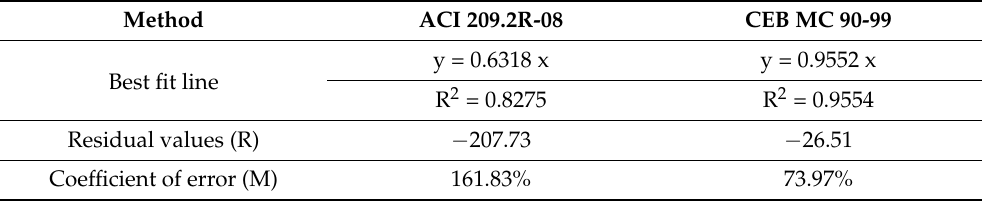
Figure 8. Evaluation of the ACI 209.2R-08 ( a ) and CEB-MC 90-99 ( b ) models by residual analysis. Table 3. Summary of quantitative evaluation of shrinkage prediction models.